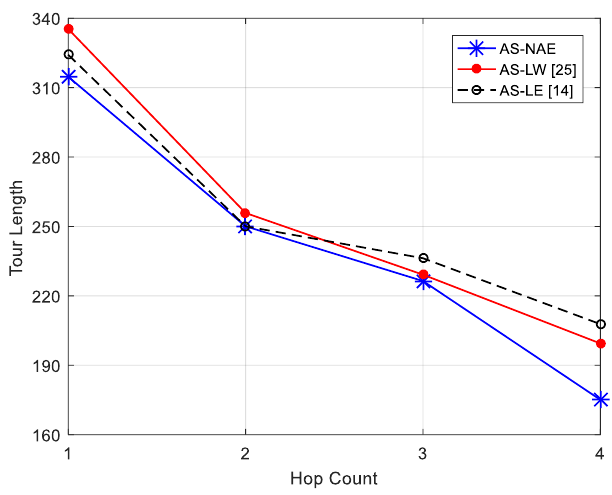
Figure 8. Impact of hop count on tour length.